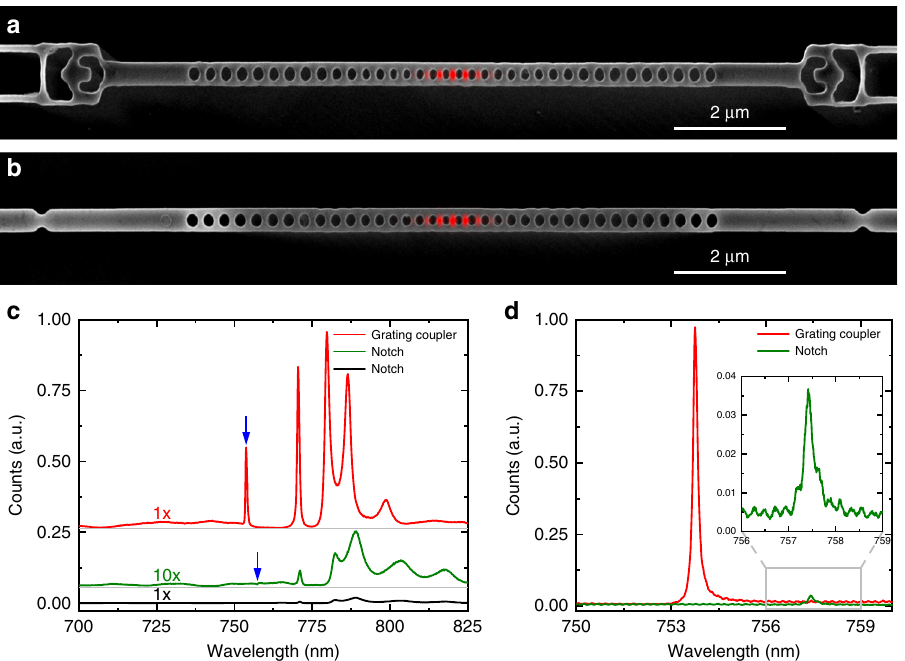
Fig. 3 Suspended rectangular diamond nanobeams with optical interfaces. Scanning electron micrographs of nanobeam photonic crystal cavities in a with inverse-designed vertical couplers and in b with notches as interfaces for in- and out-coupling. Fields inside the cavities are depicted in red. c Transmission measurements using a supercontinuum light source. The red spectrum corresponds to the coupler device in a , black and green spectra to the notch device in b . The spectra are offset for better visualization and the cavity resonances are indicated by blue arrows. d Spectra acquired by coupling a supercontinuum light source directly to the cavity and out through a vertical coupler (red line) or a notch (green line). Inset corresponds to the data inside the gray